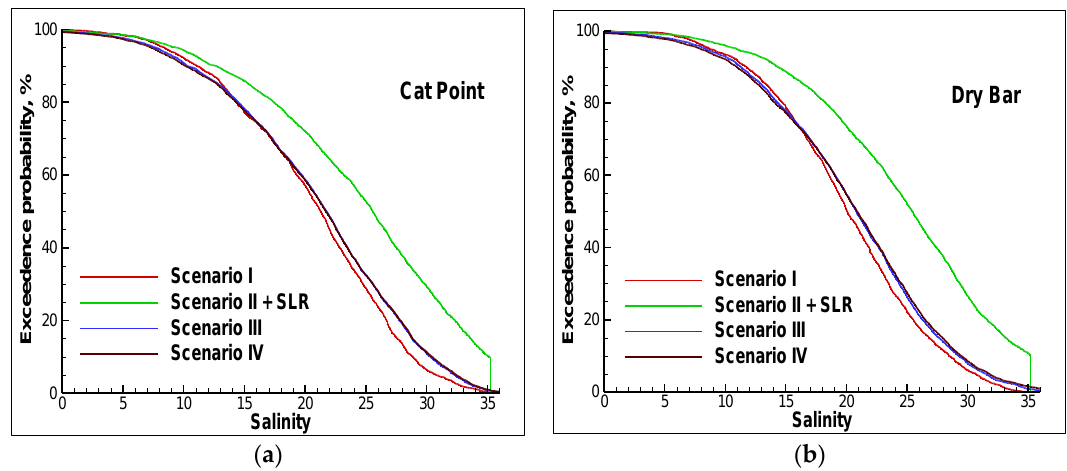
Figure 11. Exceedance rate of salinity at Cat Point (a) and Dry Bar (b) stations. Scenario 2 with sea level rise effects.